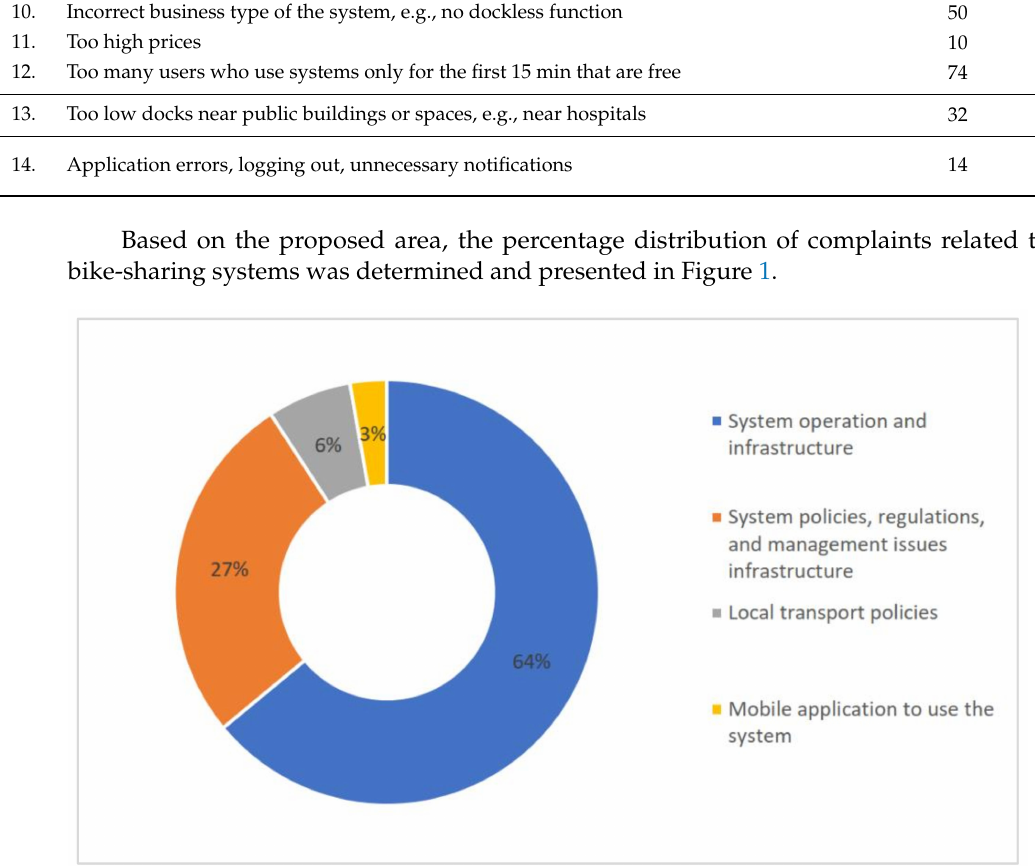
Figure 1. Percentage distribution of complaints areas in bike-sharing